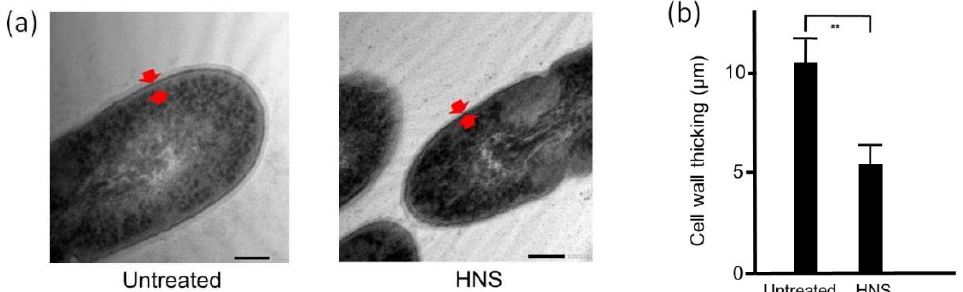
Figure 5. Inhibitory e ff ects of the HNS on the S. mutans -formed biofilm, measured by transmission electron microscopy (TEM). S. mutans cells were treated with HNS (500 µ g / mL) for 24 h. The samples were examined by transmission electron microscopy. ( a ) Representative photo. Red arrow shows the cell wall. ( b ) The thickness was measured at six arbitrary points in the bacteria treated with HNS and in untreated bacteria. Data demonstrate the mean ± SD ( n = 6). **: p < 0.01 by Student’s t ‐test).